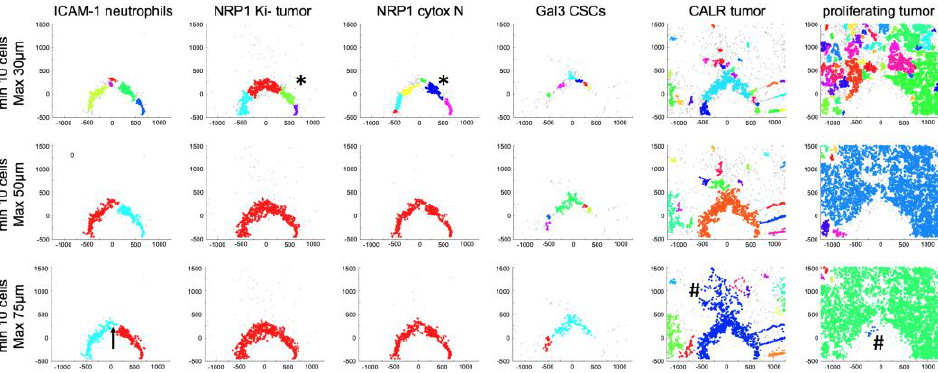
Figure 7. Distance-based clustering of panobinostat-induced cell types in situ. Clusters were identified by the presence of a minimum of ten cells within maximum distance ranges of 30 ( top ), 50 ( middle ), and 75 ( bottom ) µ m for the depicted cell types (titles). Individual cells are shown as gray points; treatment-specific clusters are depicted with a randomized color. Clusters within the maximum distance range merged and share the same color. Signs “*” and “#” mark fragmented or treatment-unspecific clusters, respectively. Coordinate [0,0] identifies the drug source. An arrow (bottom left) shows the direction of drug